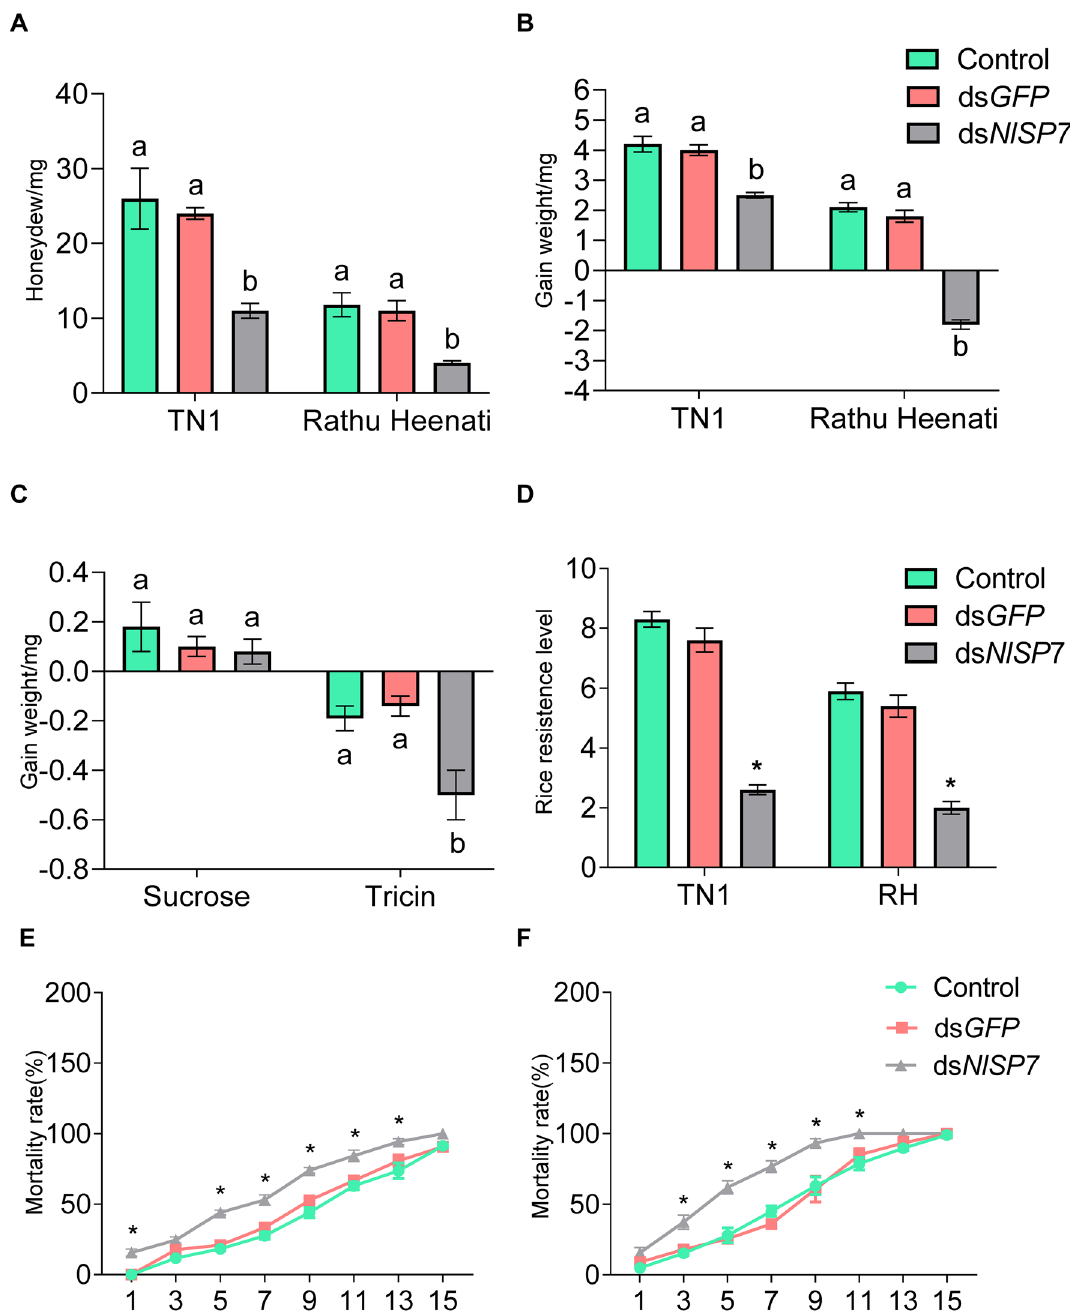
Figure 3. RNA interference (RNAi) effects on feeding of brown planthoppers (BPHs) exposed to three different treatments (control, injected with ds GFP , injected with ds NlSP7 ) and resistance levels of different rice varieties. ( A ) On Taichung Native 1 (TN1) and Rathu Heenati (RH) rice varieties, the mean honeydew amounts excreted at 24 h by a female adult BPH that received three treatments. The experiment was repeated with 20 replicates. ( B ) Weight gain of BPHs fed TN1 and RH rice varieties after injection with different dsRNA treatments. ( C ) Mean weight of BPHs fed LDS-sucrose and LDS-tricin (mean ± SD, n = 20). Letters indicate significant differences ( P < 0.01, Duncan’s multiple range test). ( D ) Rice resistance levels of BPHs fed TN1 and RH rice varieties. The experiment was repeated three times. Data are represented as the mean ± SD ( P < 0.01, Duncan’s multiple range test). ( E ) mortality rate of BPHs fed RH rice, repeated 10 times, respectively. ( F ) mortality rate of BPHs fed an artificial diets with 100 mg/l tricin, repeated 10 times. Asterisks (*) indicate significant difference ( P < 0.05, Student’s t